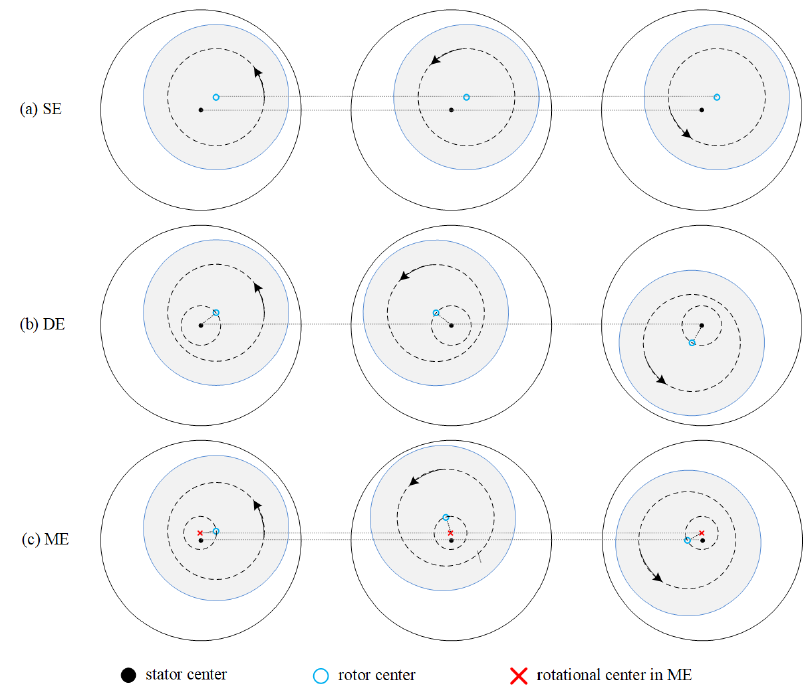
Figure 1. Diagram of RE. ( a ) SE. ( b ) DE. ( c ) ME.